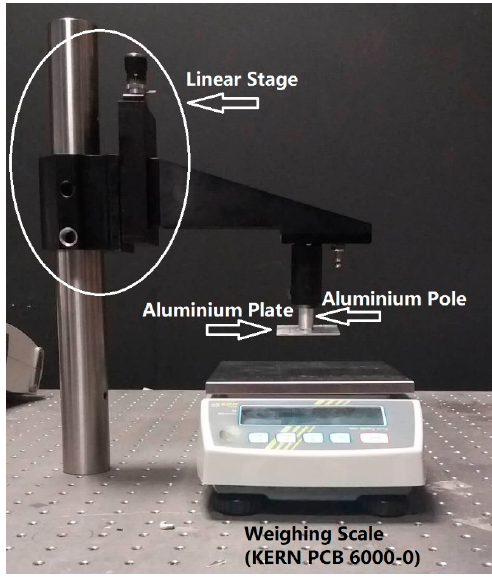
Figure 3. Pressure sensor calibration setup.